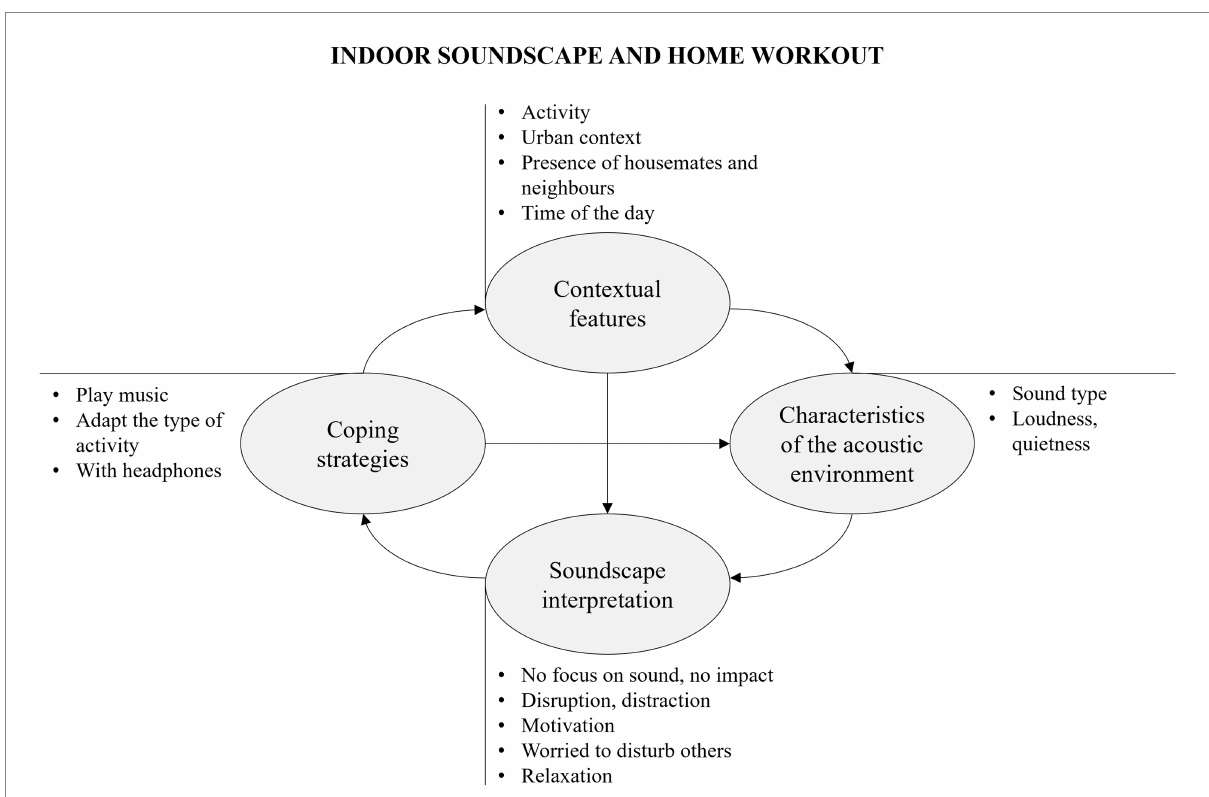
FIGURE 3 Thematic map on the relationship between indoor soundscape and home workout showing themes (within rounded boxes) and sub-themes, together with their causal